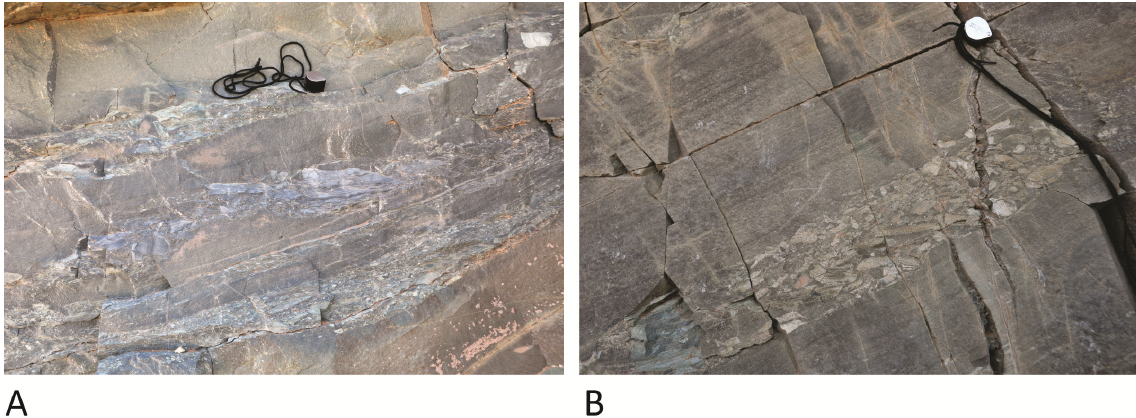
Figure 16. Examples of intraformational conglomerate, Zaydi formation. ( A ) Three beds of upward-fining conglomerate to sandstone; ( B ) Bed of conglomerate interbedded with laminated sandstone. In both examples, the conglomerate comprises rip-up clasts of siltstone. The clasts are conspicuously imbricated, denoting deposition in a high-energy aqueous environment and indicative of current direction (to the left, in these examples; to the east, in the field). Hand lens for scale-2.5 cm